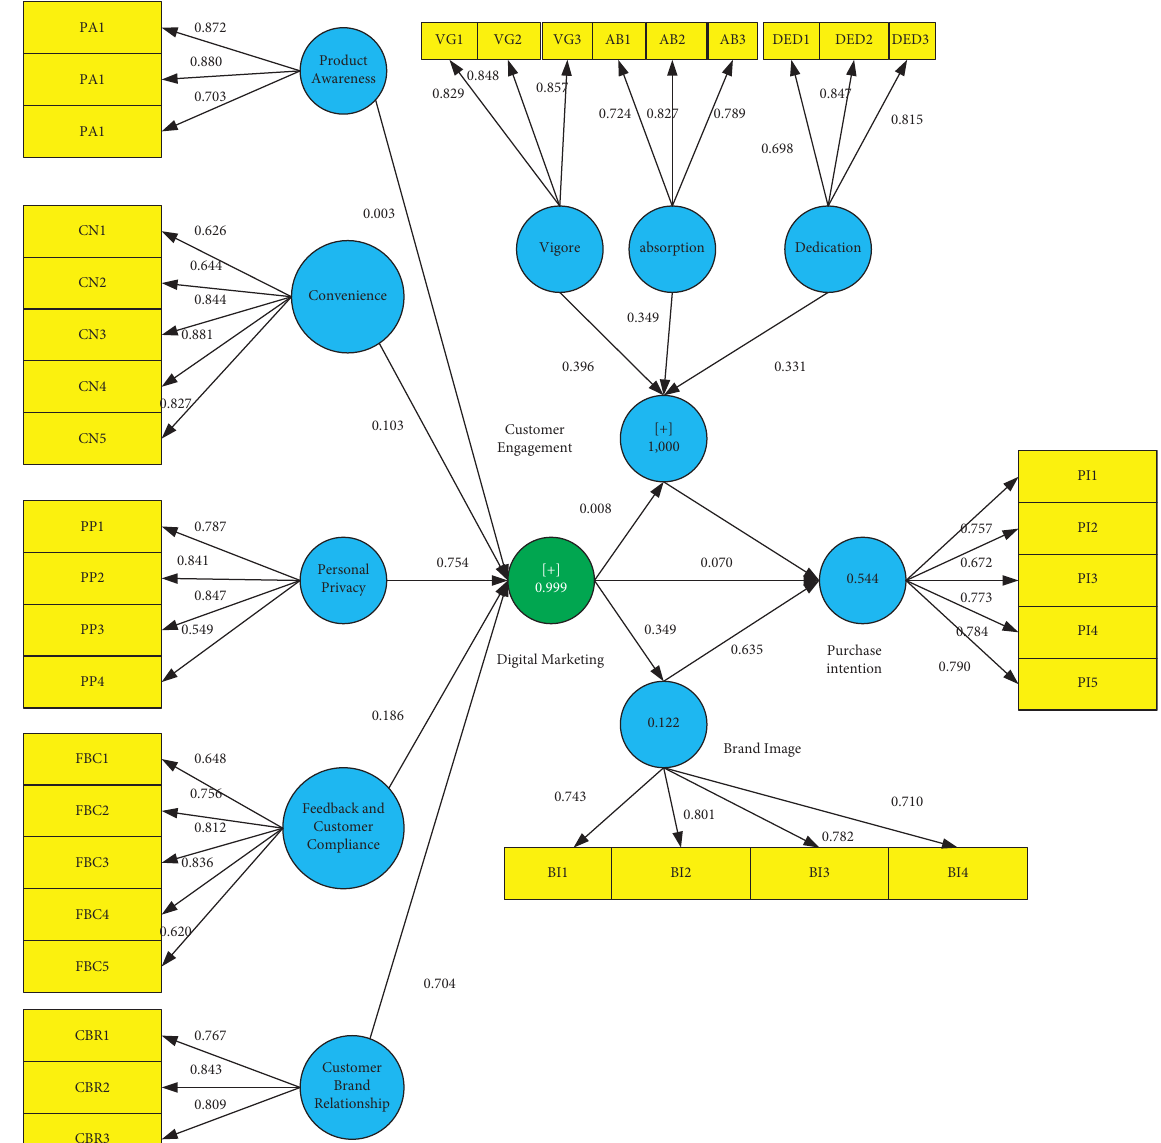
Figure 2: Structural model with